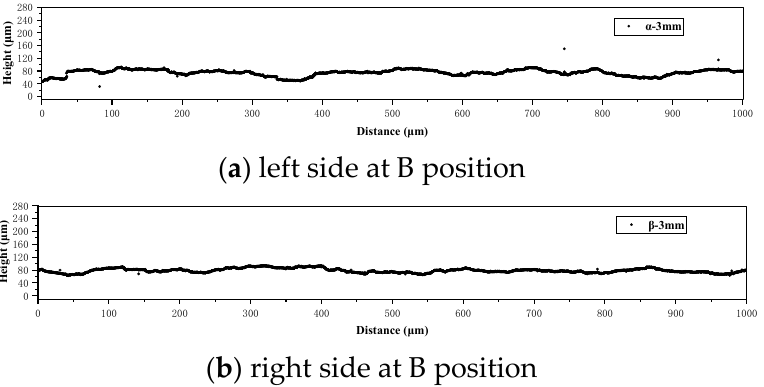
Figure 7. The etched surface heights ( h es ) of left side ( α ) and right side ( β ) at B position (3 mm to bloom edge) in the inner curve side under 20 °C superheat: ( a ) left side, ( b ) right side. (The measuring length of each side is 1.0 mm, and there are 1001 points with 0.25 μ m intervals along the distance).